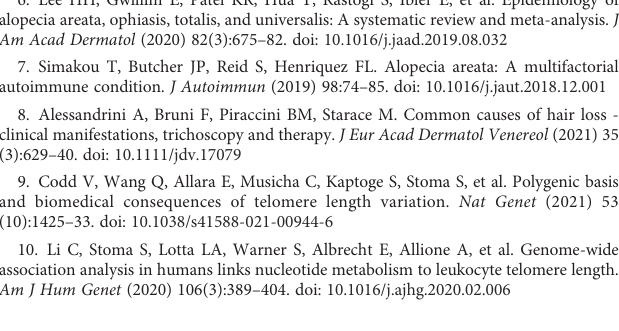
SUPPLEMENTARY FIGURE 1 Forest plot of leukocyte telomere length and risk of androgenetic alopecia (A) and alopecia areata (B) . SUPPLEMENTARY FIGURE 2 Leave-one-out analyses for the effect of leukocyte telomere length and non- scarring alopecia. (A) Analysis of leukocyte telomere length and androgenetic alopecia; (B) Analysis of leukocyte telomere length and alopecia